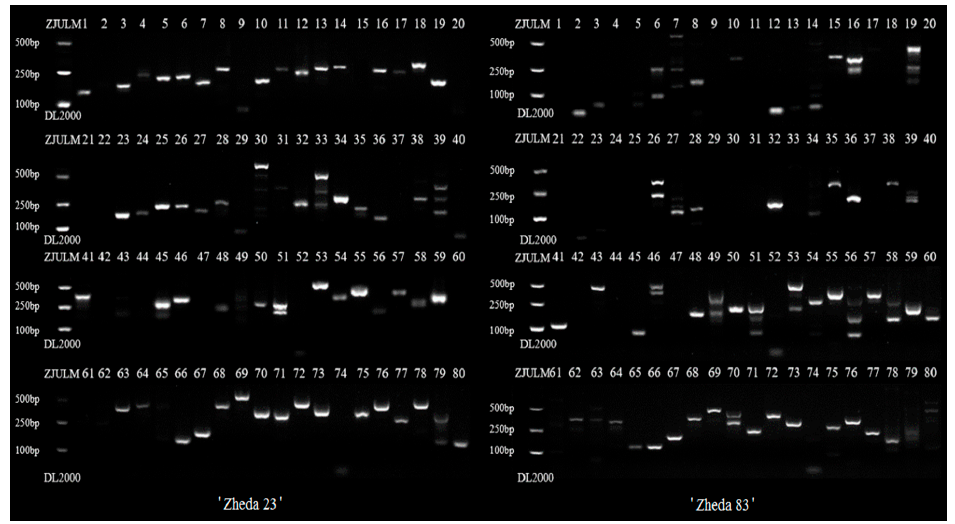
Figure 5. Result of PCR products on 3% agarose gel at 110V. (Two inbred cultivars, “Zheda 23” ( L.